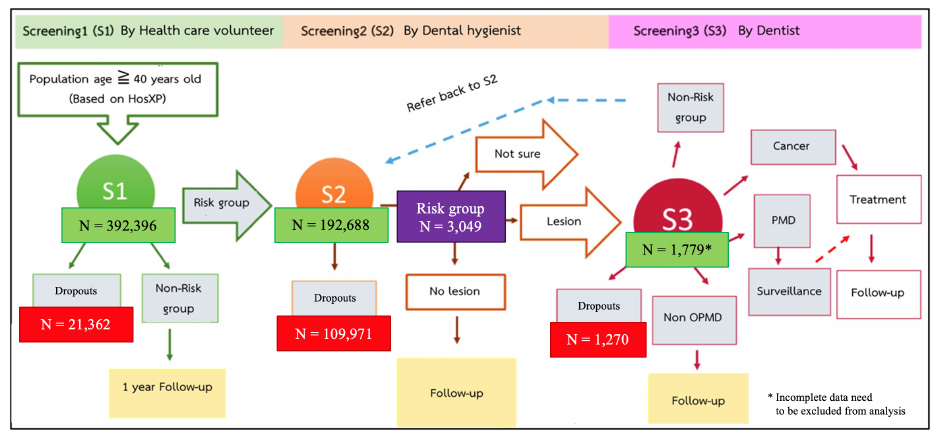
Figure 1. Diagram of project